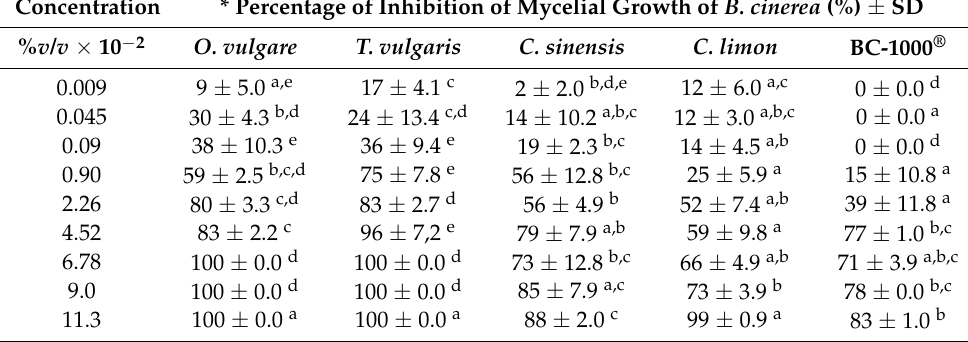
Figure 2. Effect of HYSs, obtained from O. vulgare , T. vulgaris , C. sinensis , and C. limon , on mycelial growth of B. cinerea in PDA. HYSs were added in aqueous solution at different concentrations (% v / v ): ( C-A – C-E ) (negative control), 0.0; ( A1 – D1 ) 0.02; ( A2 – D2 ) 0.2; ( A3 – D3 ) 1.0; ( A4 – D4 ) 10; ( A5 – D5 ) 25. The values of growth inhibition percentage induced by EOs and HYSs for all studied essential oils are given in Tables 1 and 2, respectively. Table 1. Percentage of inhibition of B. cinerea mycelial growth induced by different concentrations (% v / v ) of T. vulgaris , O. vulgare , C. sinensis , and C. limon EOs, three days after incubation. Concentration * Percentage of Inhibition of Mycelial Growth of B. cinerea (%) ±